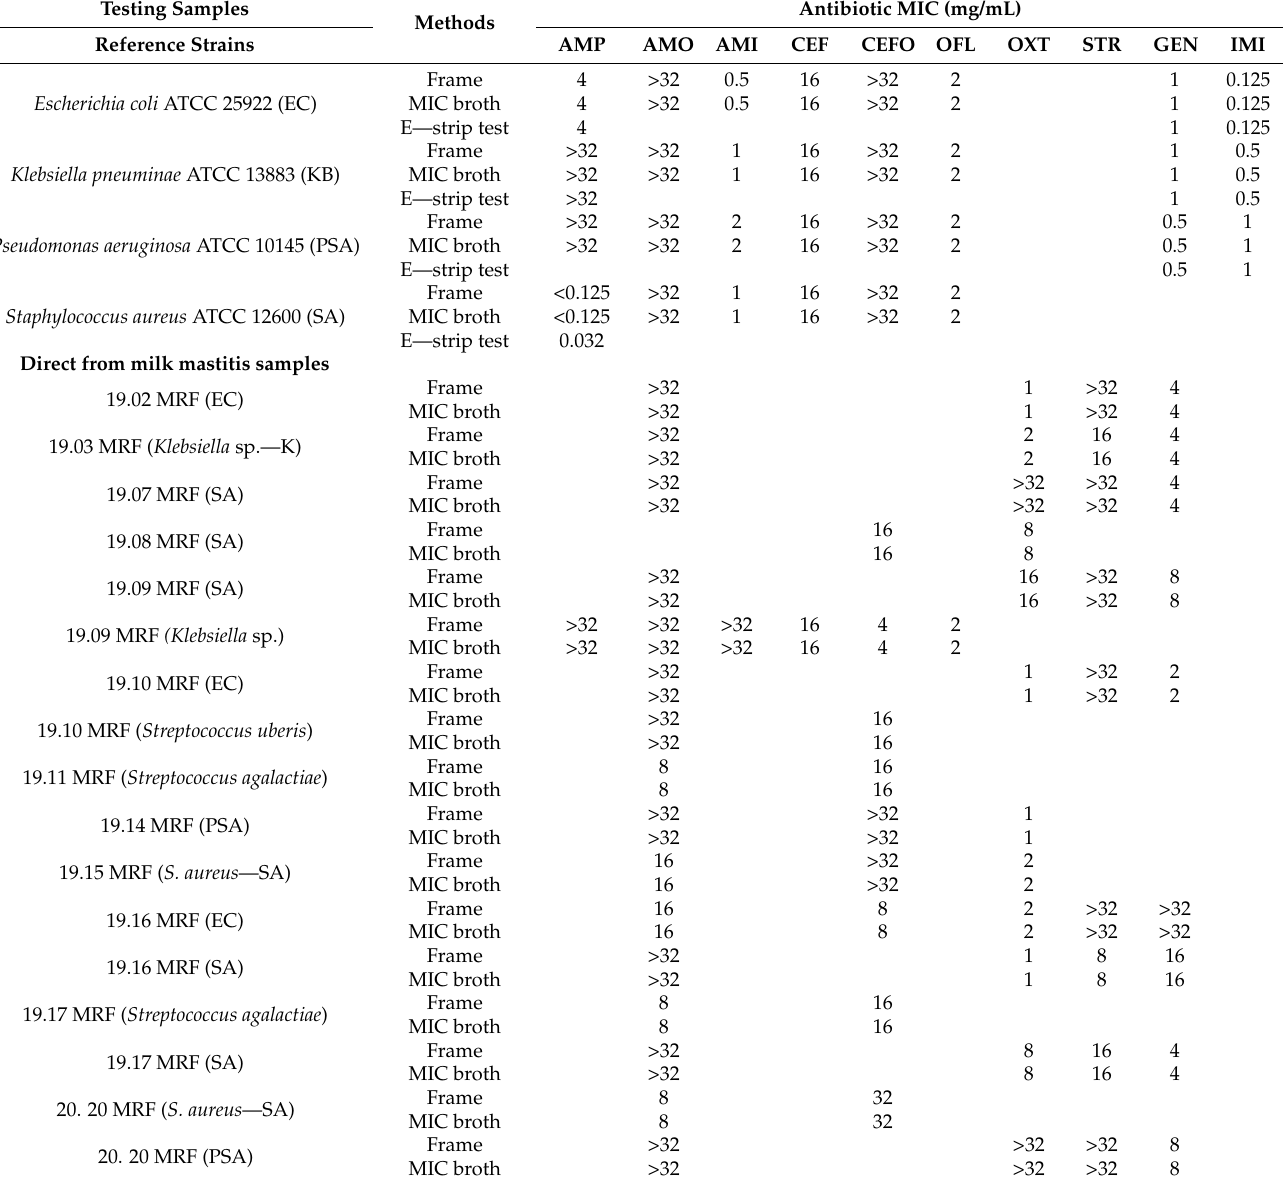
Table 1. Comparison frame dip slide vs. broth microdilution to individual